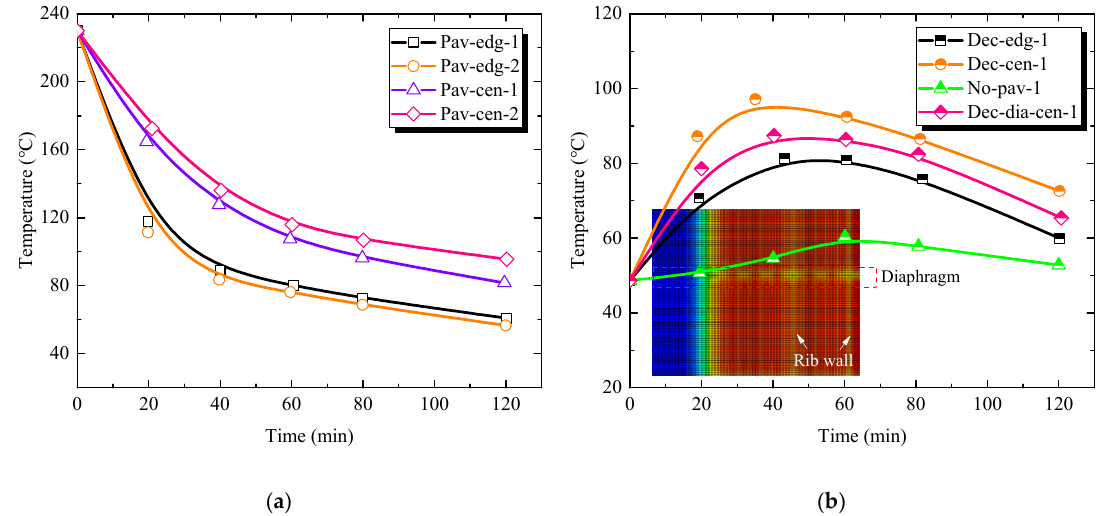
Figure 13. Variation of simulated temperatures. ( a ) Pavement surfacing; ( b ) deck plate.